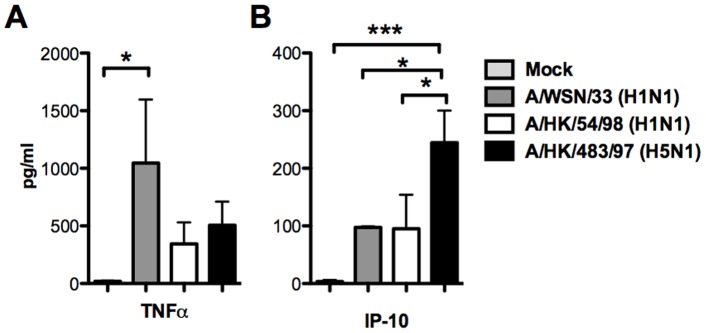
Cytokine and chemokine secretion from mouse bone marrow derived macrophages after influenza A virus infection.(A) TNF-α (B) IP-10 protein secreted by the mouse bone marrow derived macrophages after influenza A viruses infection (as denoted in legend). Mean and standard error of duplicate assays are shown. All influenza A virus infected mouse macrophages secrete significantly higher concentration of TNF-α than mock infected cells (p<0.05).